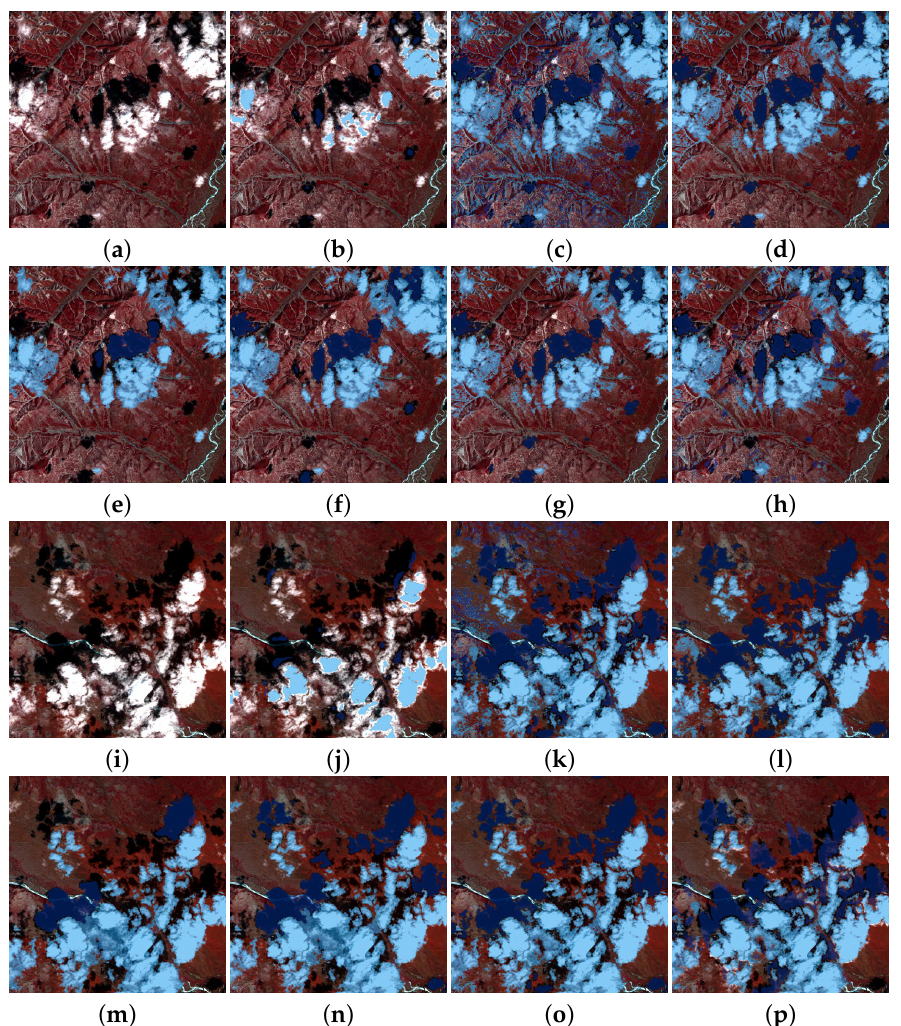
Figure 5. Typical visual examples of local patches (1). ( a , i ) False-color (Bands 5 NIR, 4 Red, and 3 Green) images, ( b , j ) Reproduced PSPNet [1,31], ( c , k ) UNet × α [1], ( d , l ) Global Refined UNet [1], ( e , m ) Refined UNet v2 [2], ( f , n ) Refined UNet v3 [7], ( g , o ) Refined UNet v4, ( h , p ) QA reference.